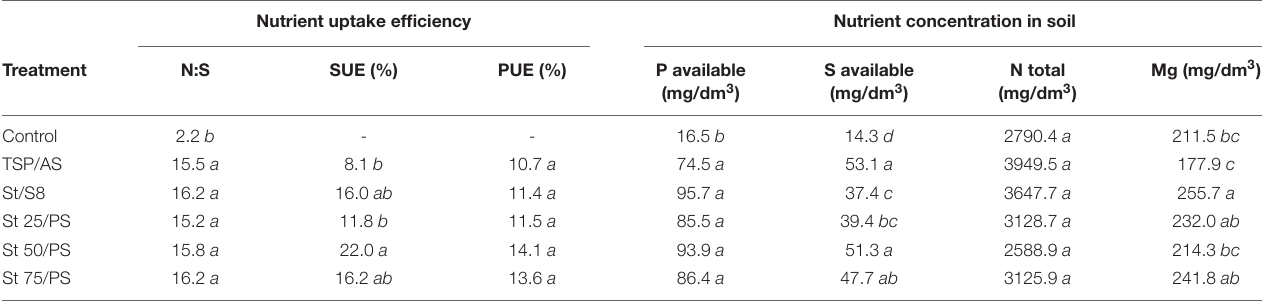
Nutrient uptake